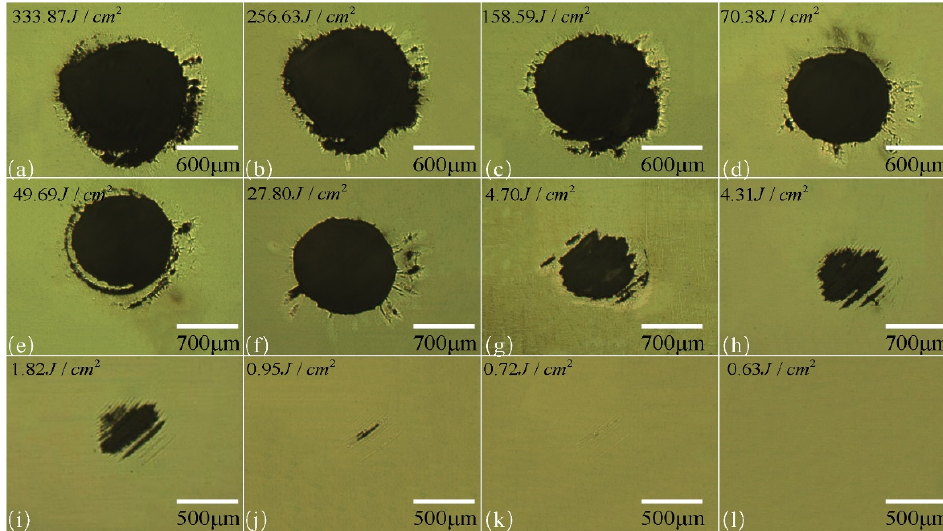
Figure 3. The damage morphology under different laser fluence.